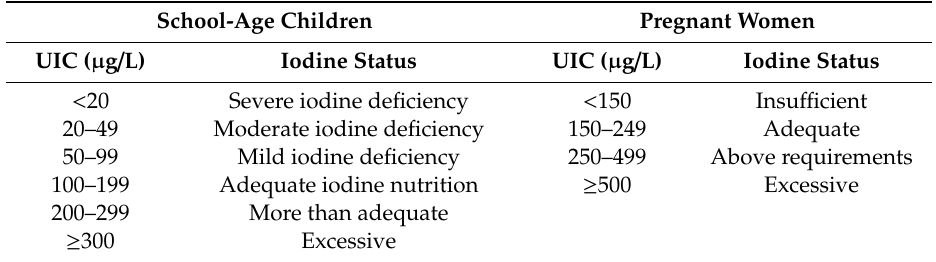
Table 1. Median urinary iodine concentrations (UIC) and iodine status in school-age children and pregnant women according to the World Health Organization (see reference